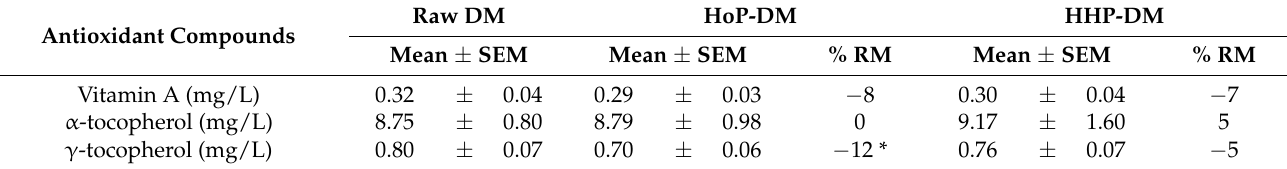
Table 2. Concentrations of some antioxidant vitamins in raw-, Holder (HoP)- and High Hydrostatic Pressure (HHP) pasteurized -donor milk (DM). Data are presented as mean ± SEM. Asterisks correspond to level of statistical significance for paired comparisons with RM. * p < 0.05.